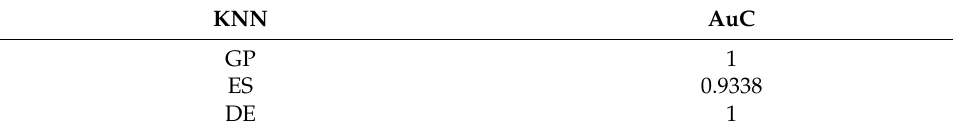
Table 2. AuC of KNN spectrum sensing method based on GP, ES and